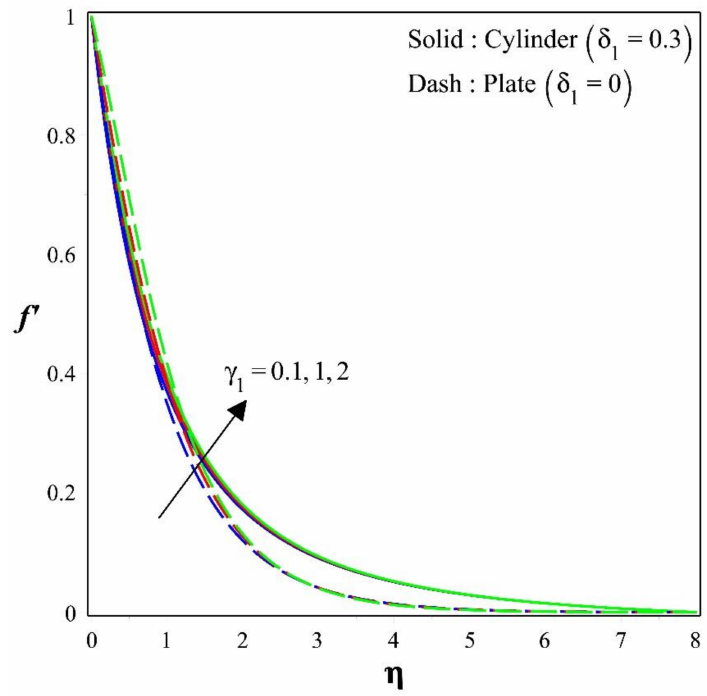
Figure 4. The role of mixed convection parameter on velocity profile (keeping P m = 0.1, ζ = 30 0 , φ 1 = φ 2 = φ 3 = 0.01& H SS =